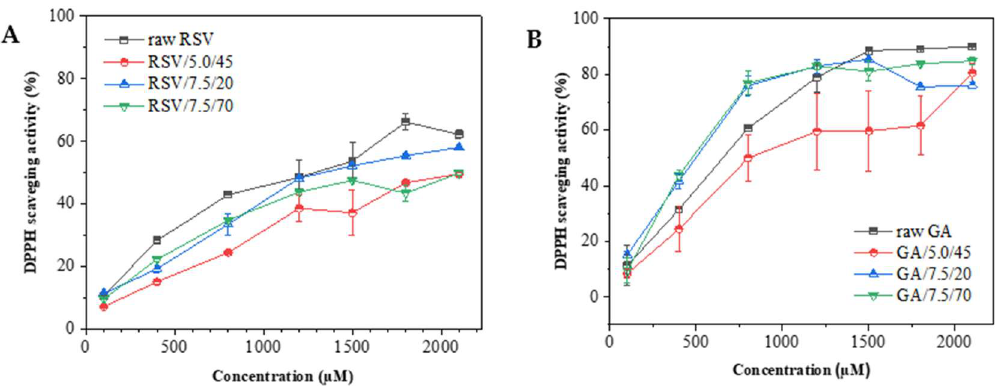
Figure 8. Antioxidant activity of raw materials and SASD-processed formulations with ( A ) RSV and ( B ) GA.